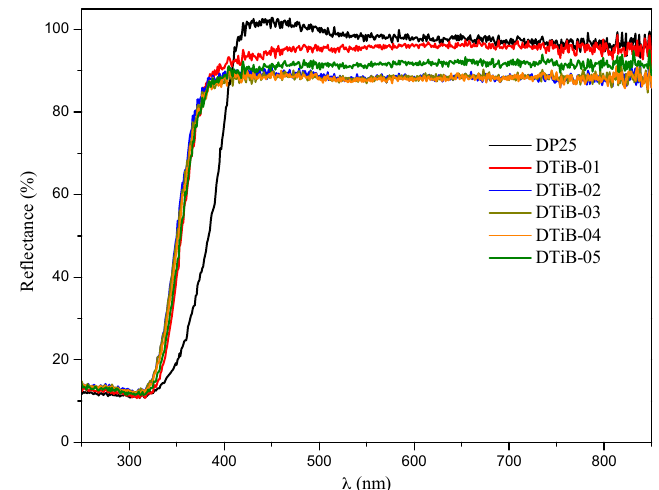
Figure 7. Diffuse reflectance ultraviolet–visible spectroscopy (DRS UV-vis) spectra for all the CD-aTiO 2 samples prepared in this work and for the commercial DP25 TiO 2 .